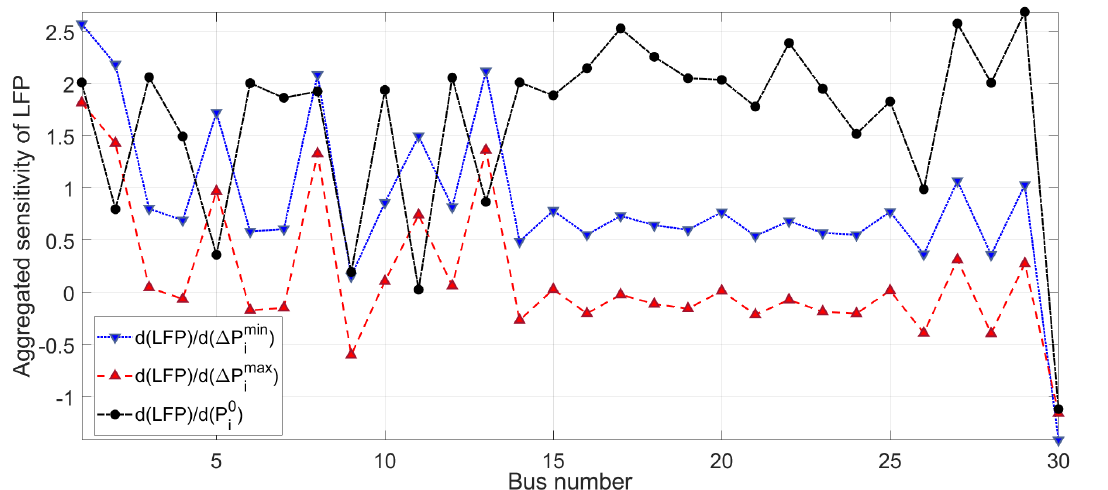
Figure 6. Aggregated impact of perturbations in lower and upper bound of flexibility (blue and red lines), and base-power program (black line) at each bus on the LFPs of the whole network in Case